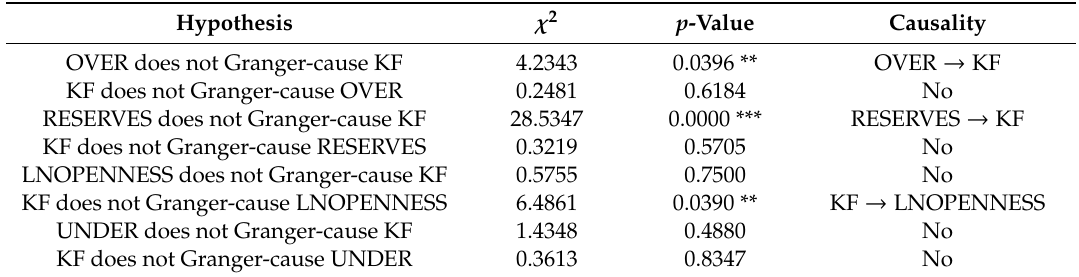
Table 8. Causality between KF, OVER, UNDER and